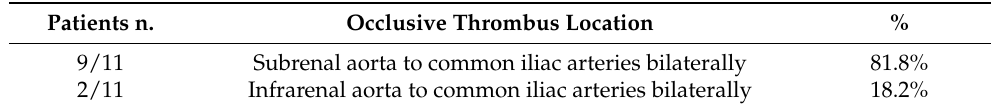
Figure 2. ( A ). CT angiography, coronal planes, arterial phase, MIP reconstruction. Aortic complete occlusion in the subrenal tract. Thrombosis located also in the left renal artery and extended until left common femoral artery can be noted (in our study found in 3/11 patients). ( B ). CT angiography, coronal planes, arterial phase. Aortic complete occlusion in the infrarenal tract, located at the origin of the right renal artery. Table 3. Location of the aortic thrombotic occlusion. Patients n.